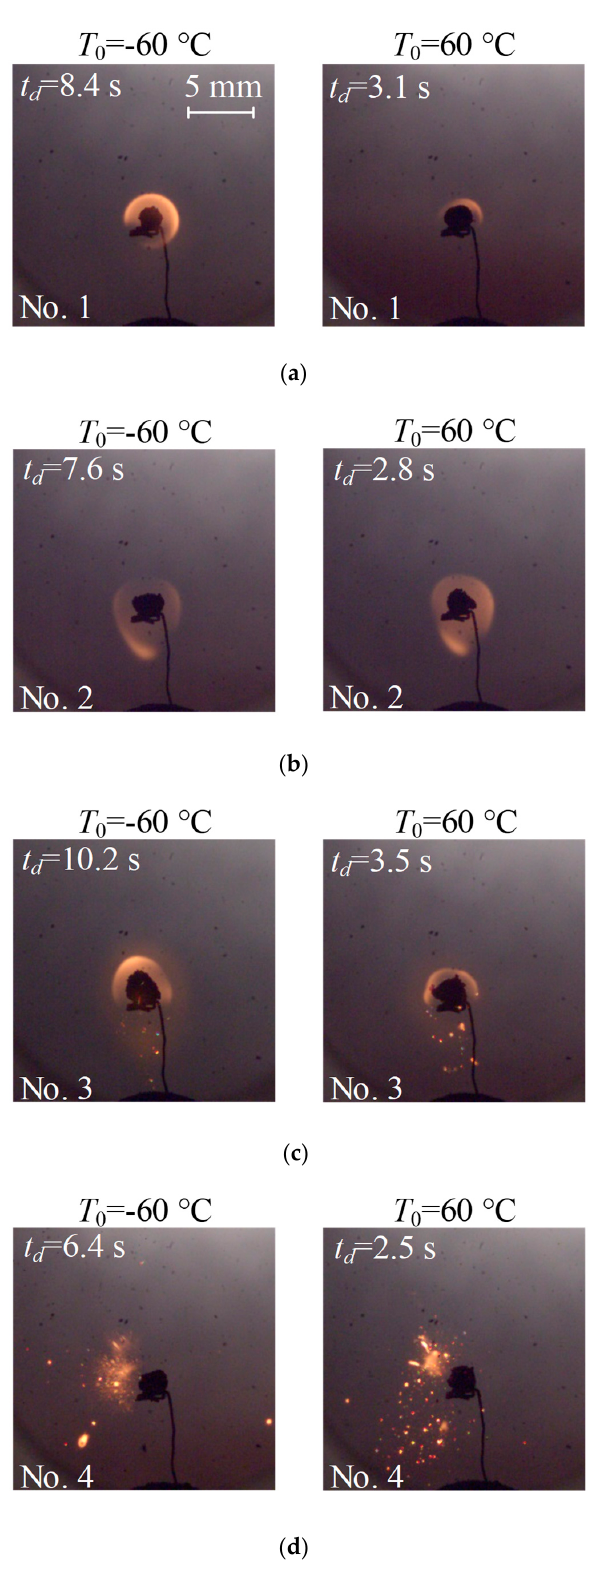
Figure 5. Video frames of the ignition moment of composite fuel droplets at different initial fuel temperatures (left— T 0 = − 60 ◦ C, right— T 0 = 60 ◦ C) and at the heating source temperature of T g = 800 ◦ C: ( a ) composition No. 1 (40% FC + 15% rapeseed oil + 45% water); ( b ) composition No. 2 (40% FC + 15% turbine oil + 45% water); ( c ) composition No. 3 (40% coal + 15% rapeseed oil + 45% water); ( d ) composition No. 4 (40% coal + 15% turbine oil + 45%